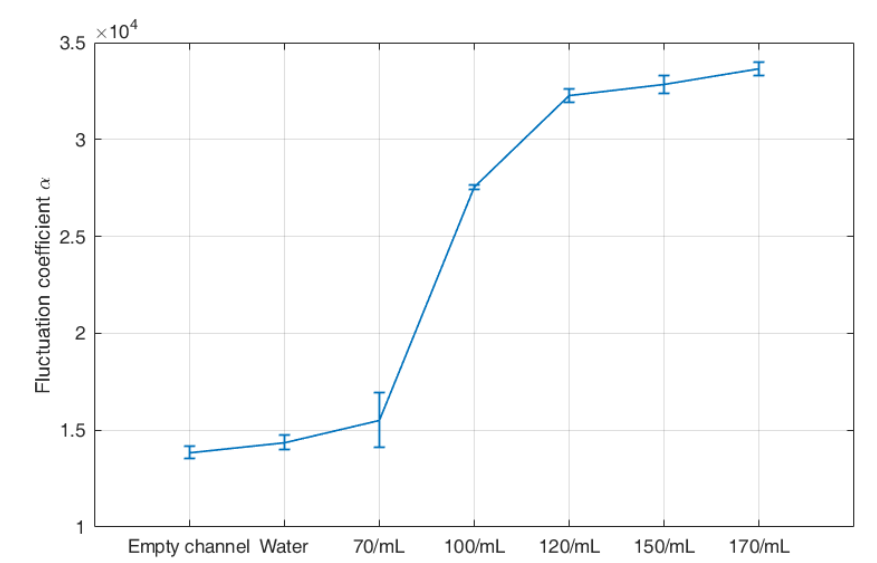
Figure 5. Fluctuation coefficient of the two-phase flow with different concentrations of plastic par- ticles.